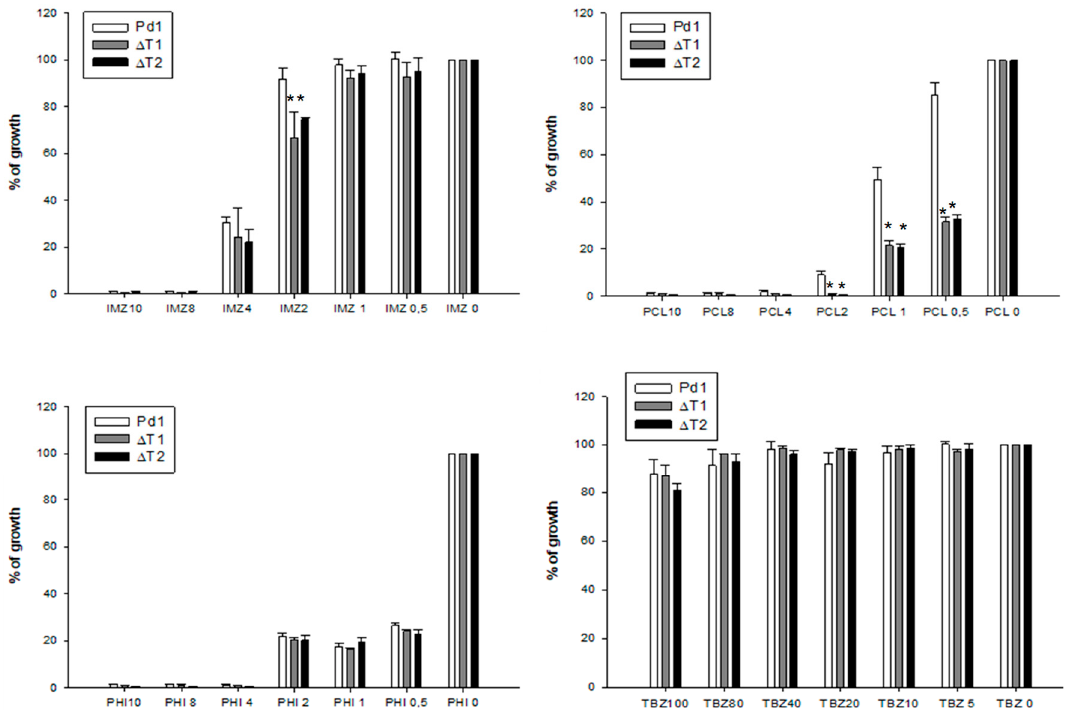
Figure 4. Evaluation of fungicide sensitivity in disruptant mutants compared to wild type Pd1. IMZ = imazalil, TBZ = Thiabendazol, PCL = Prochloraz, PHI = Philabuster. The fungicides concentration is expressed in µ g / mL. Percentage of relative growth was calculated respect to the each strain grown without fungicide. Error bars represent standard deviation among three replicas. * Significant differences between treatments using Tukey’s test ( p < 0.05).